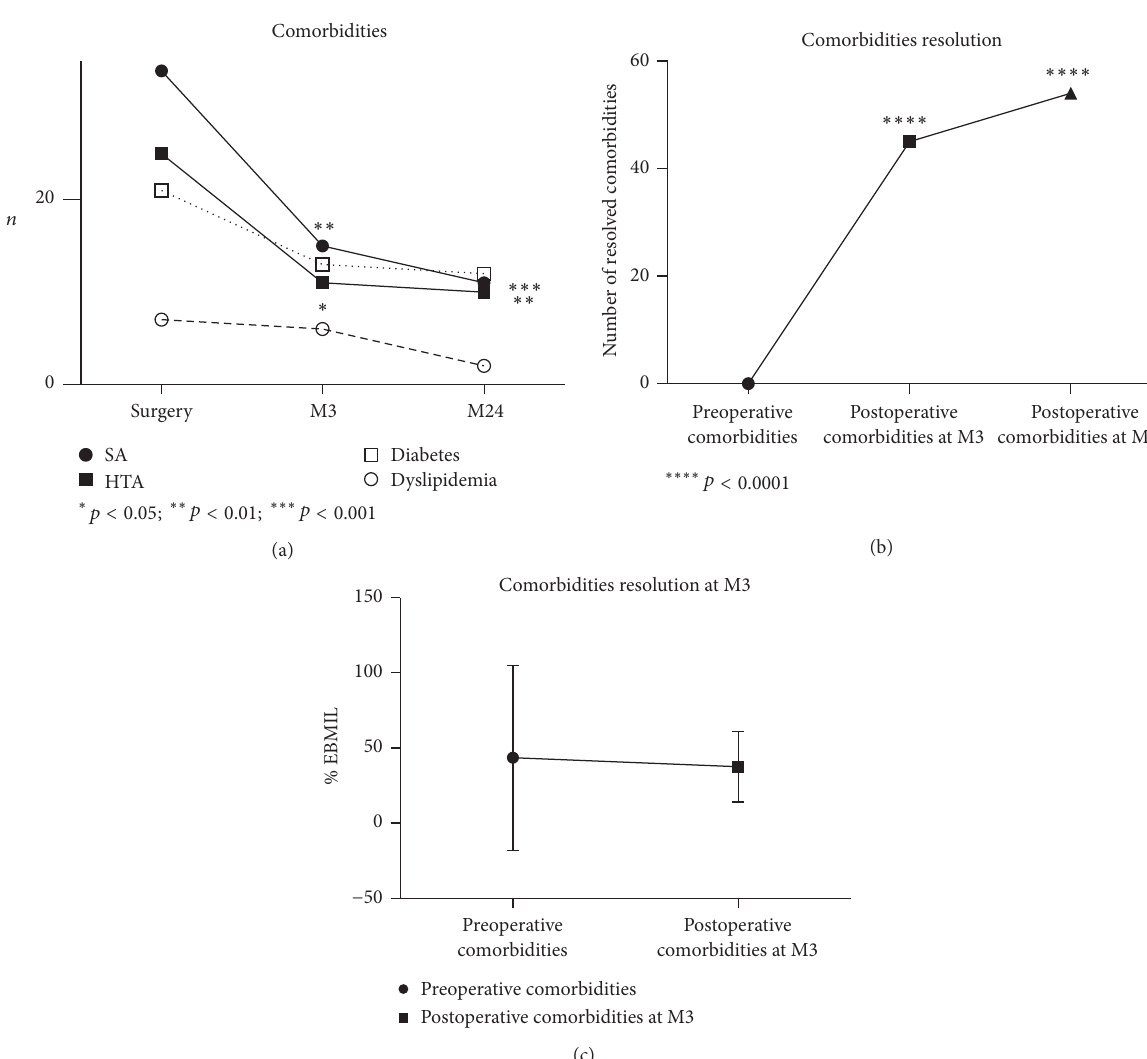
of at least 5 years with the objective of improving patient management after sleeve